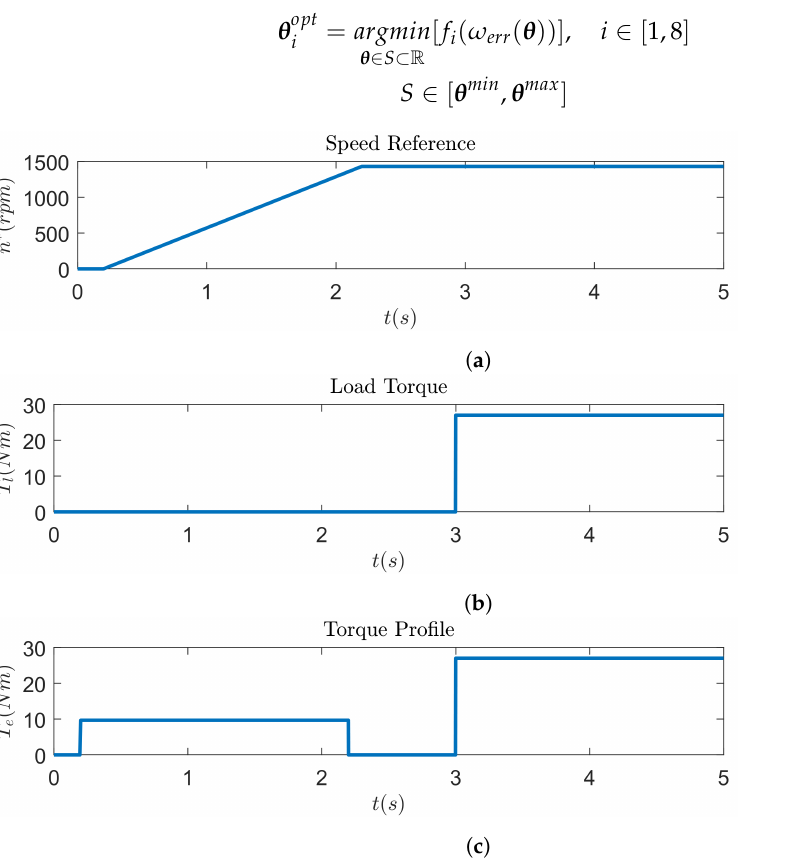
Figure 5. Drive dynamics. ( a ) Reference speed commanded to the machine. ( b ) Load torque profile applied to the machine. ( c ) Required torque